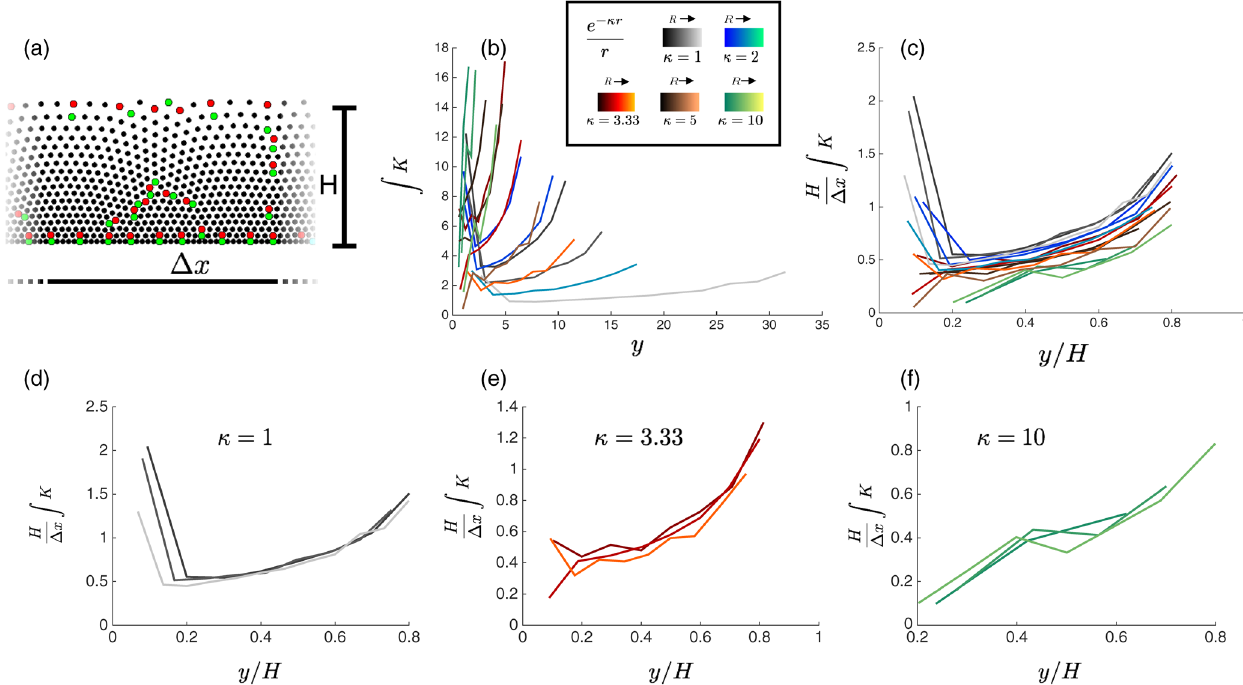
γ y . Particles form an inhomogeneous structure in the presence (2013).FIG. 13. Yukawa interacting particles in a potential of the form V ext ¼ of a barrier. The particle density increases towards the barrier. (a) Example particle configuration. Note that the entire structure is not shown, and periodic boundary conditions are used. (b, c) Scaling behavior of the integrated curvature profiles. With the additional length scale introduced by the screening length, our data suggest that the integrated curvature profiles no longer collapse when scaling the coordinates by the system size as shown in (c). (d) – (f) Structural change as the screening length is varied. In the case of sufficiently large screening length (small κ ), as shown in (d), the structure resembles that of a Coulomb system. In particular, the long-range interactions result in a concentration of integrated curvature near the barrier at y ¼ 0